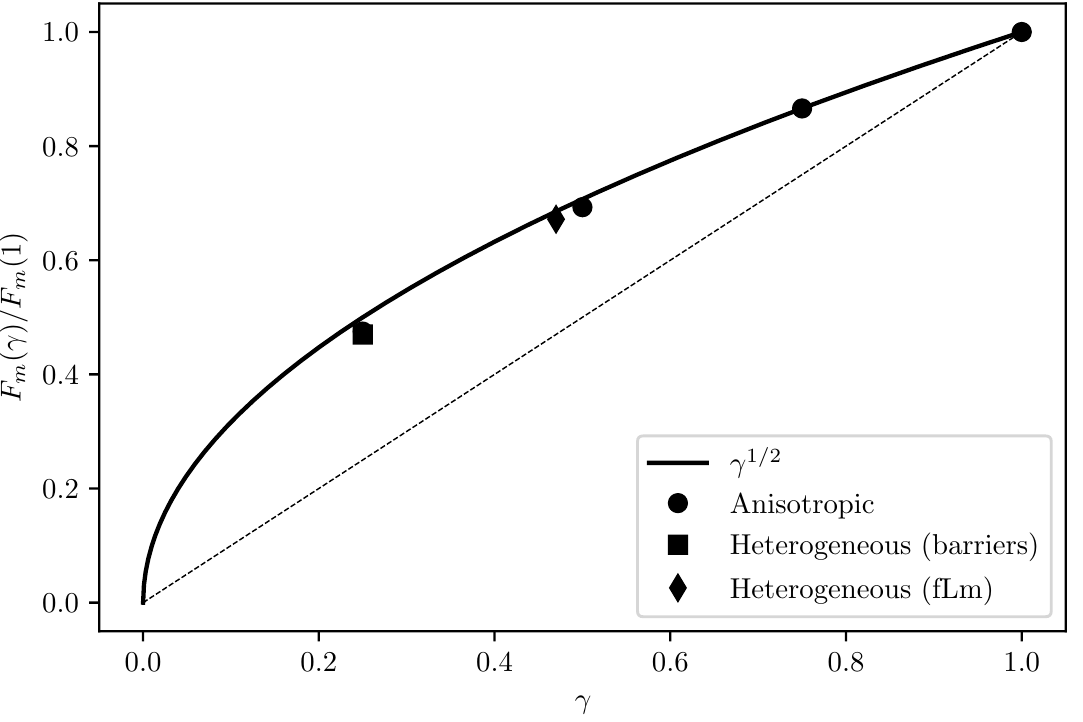
Figure 12. Steady flux F m ( γ ) scaled by F m ( 1 ) = 0.018 k h C 0 ∆ ρ g / µ . Simulation results for anisotropic porous medium with γ = 0.75,0.5 and 0.25. Solid line is the analytical model F m ( γ ) / F m ( 1 ) = γ 1/2 . Dashed line is F m ( γ ) / F m ( 1 ) = γ for reference. Note that the results for the barrier model (square) and the anisotropic media at γ = 0.25 are almost